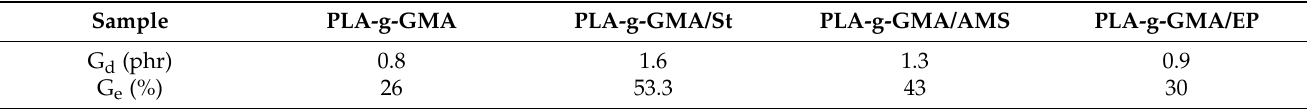
Table 4. Grafting degree (G d ) and grafting efficiency (G e ) of PLA-g-GMA graft